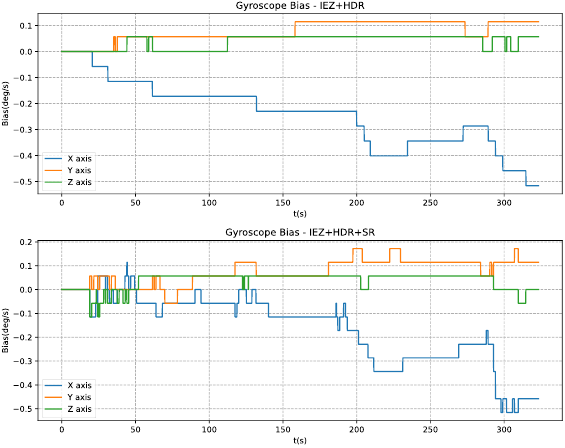
Figure 9 . Estimation of gyro bias (Experiment